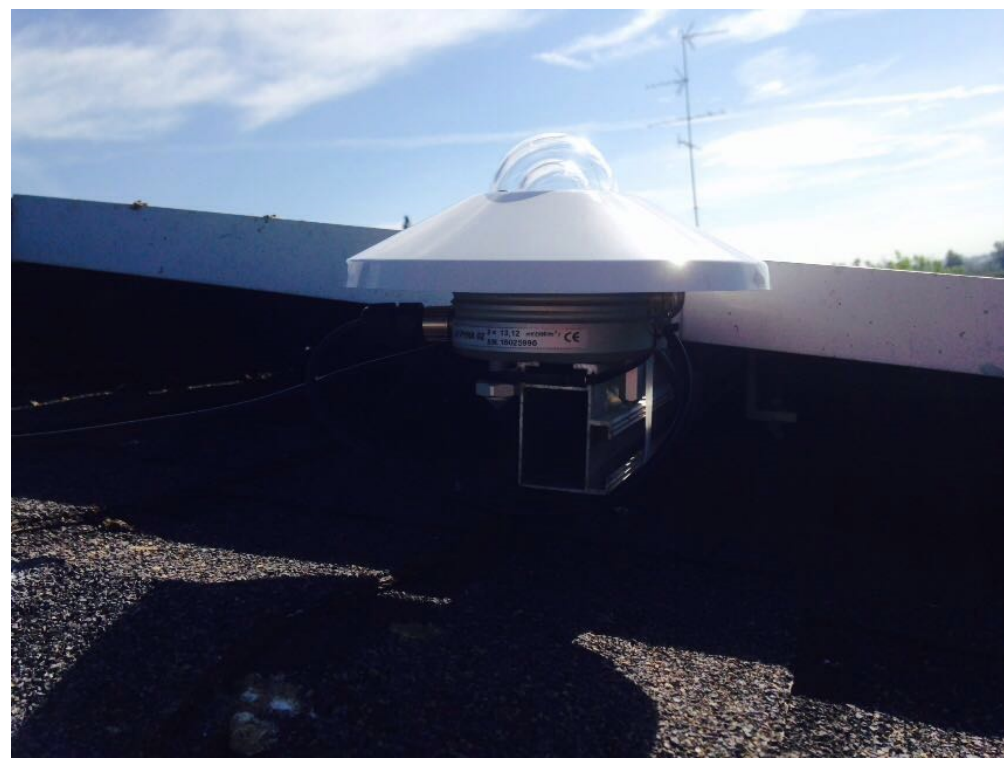
Figure 2. Delta Ohm photometer model